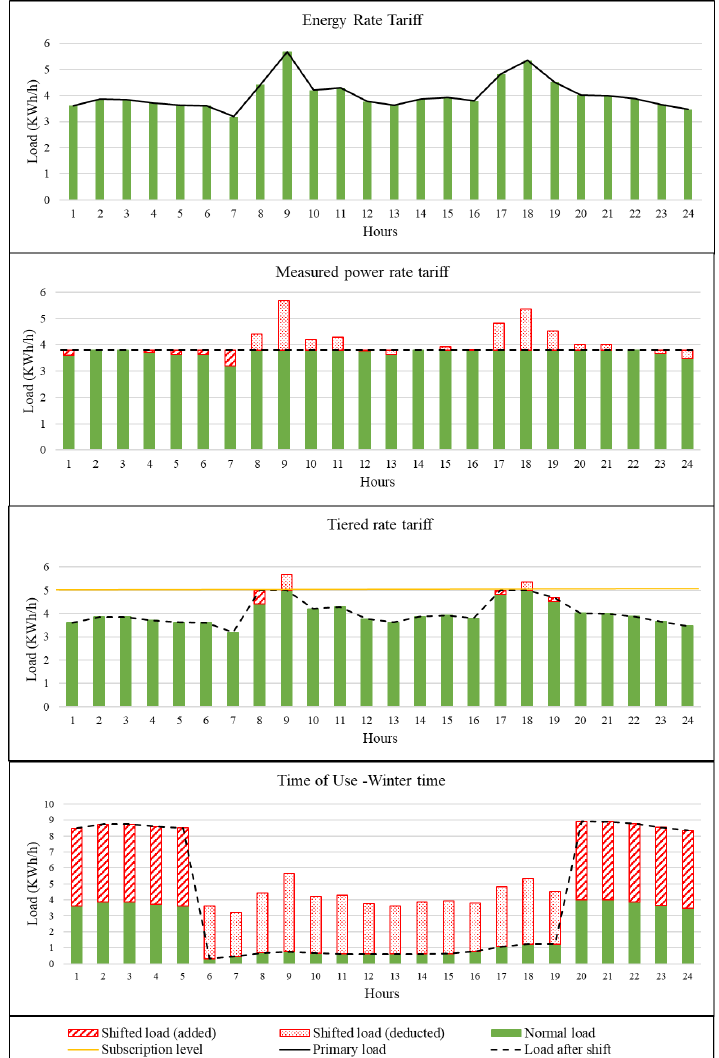
Figure 4. The winter load profiles for the ideal heat shifts of different business models of dynamic pricing